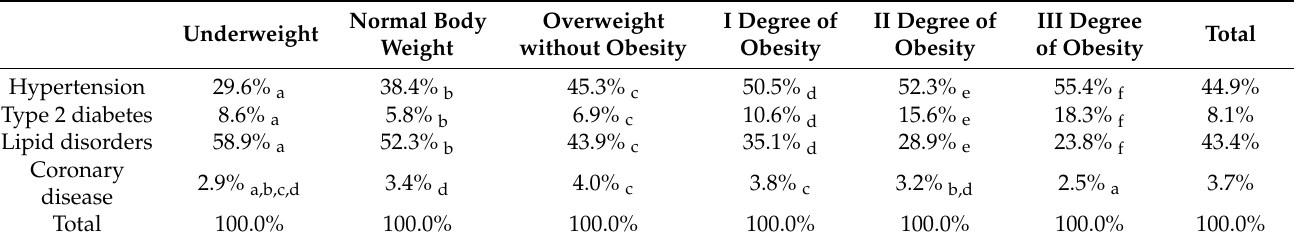
Table 7. Relationship between BMI and the incidence of selected diseases; data presented as percent- age of the BMI category 1 .